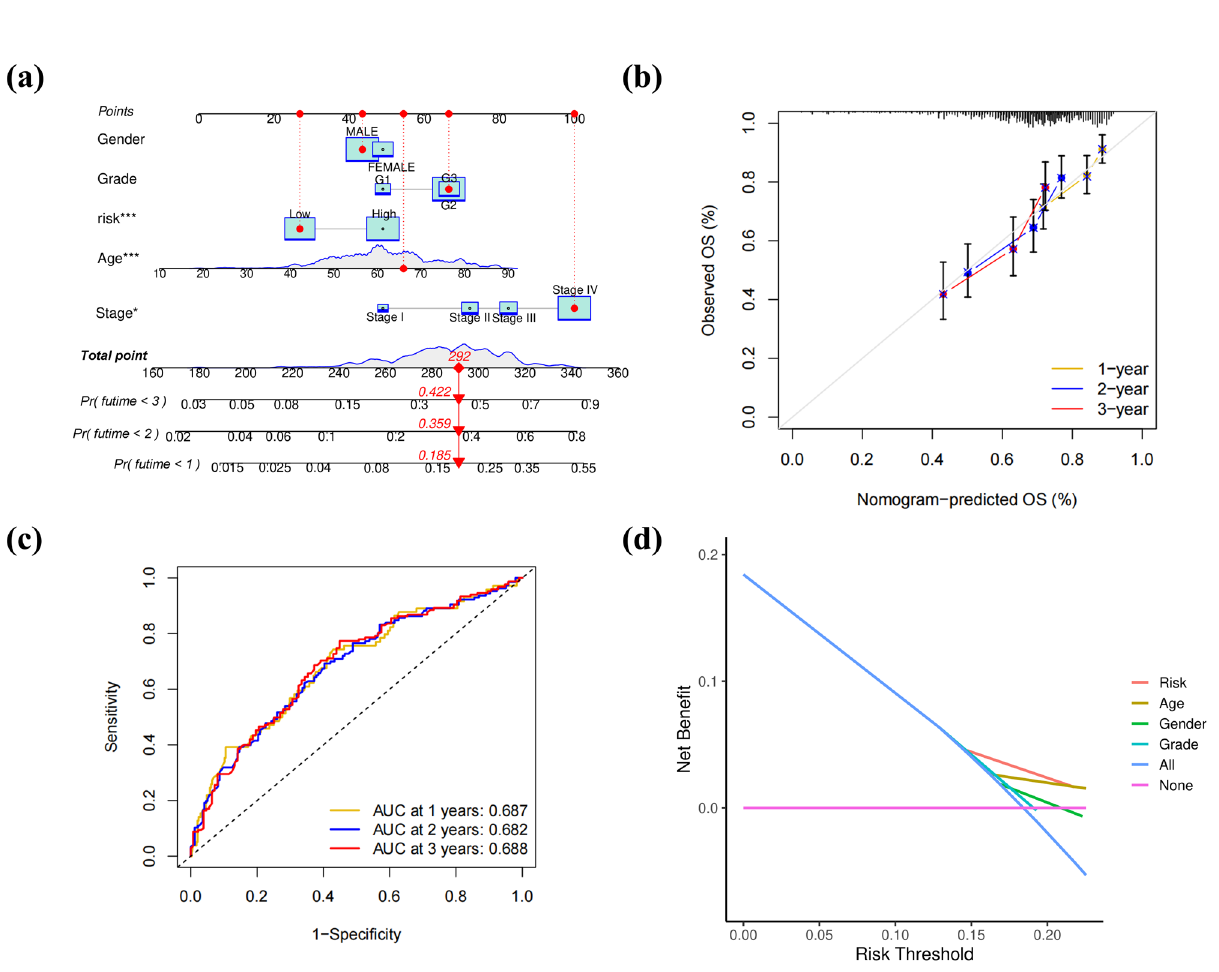
Figure 2: Construction and detection of the predictive nomogram. ( a ) Nomogram plot was built based on the prognostic factors in the whole cohort. ( b ) Calibration curve of the nomogram. ( c ) AUC of time - dependent ROC curves veri fi ed the prognostic accuracy of the nomogram. ( d ) The DCA curve of the prognostic factors indicated that risk score was the most critical factor for